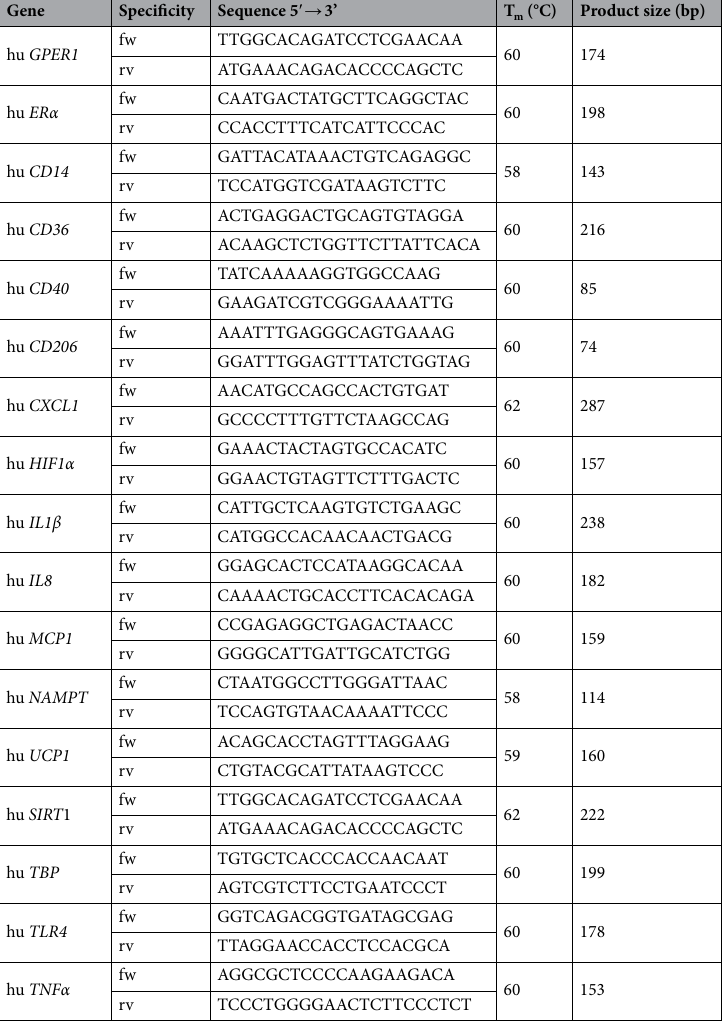
Table 1. Primers and